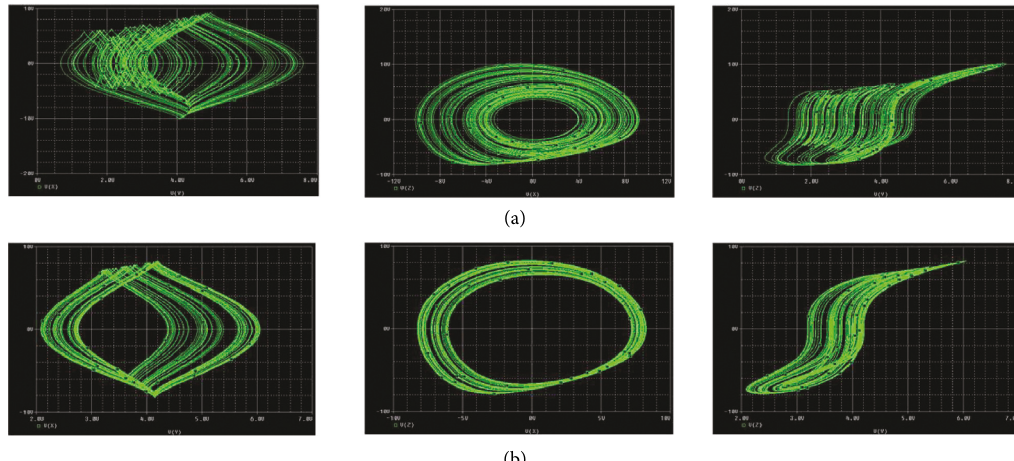
Figure 6: Phase portraits of the designed circuit obtained by using OrCAD-PSpice for (a) chaotic bursting oscillations and (b) chaotic oscillations.